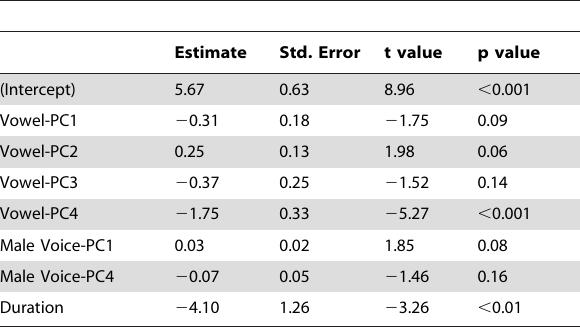
Table 10. Predictors for the regression model with